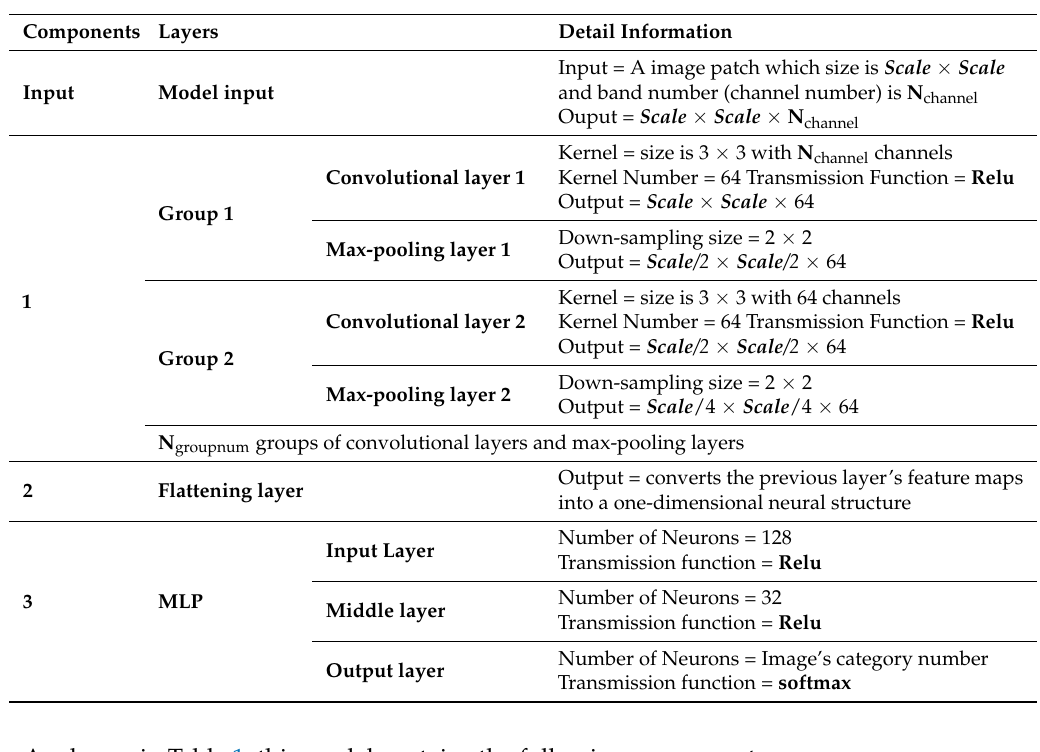
Table 1. Detailed information of the CNN